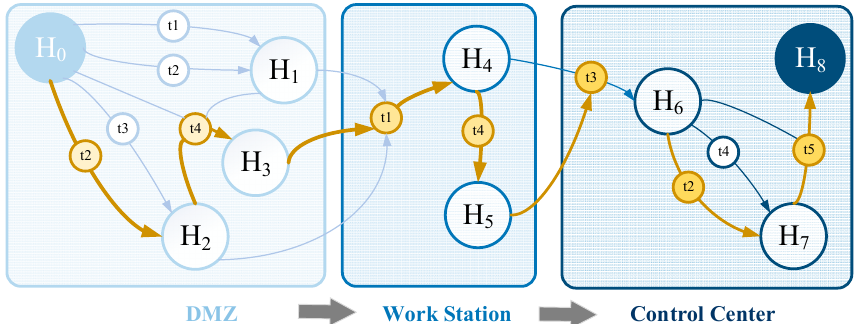
Figure 2. Attack model. t1: Input validation error; t2: Boundary condition error; t3: Buffer error; t4: Information leakage; t5: Permission acquisition and access control.